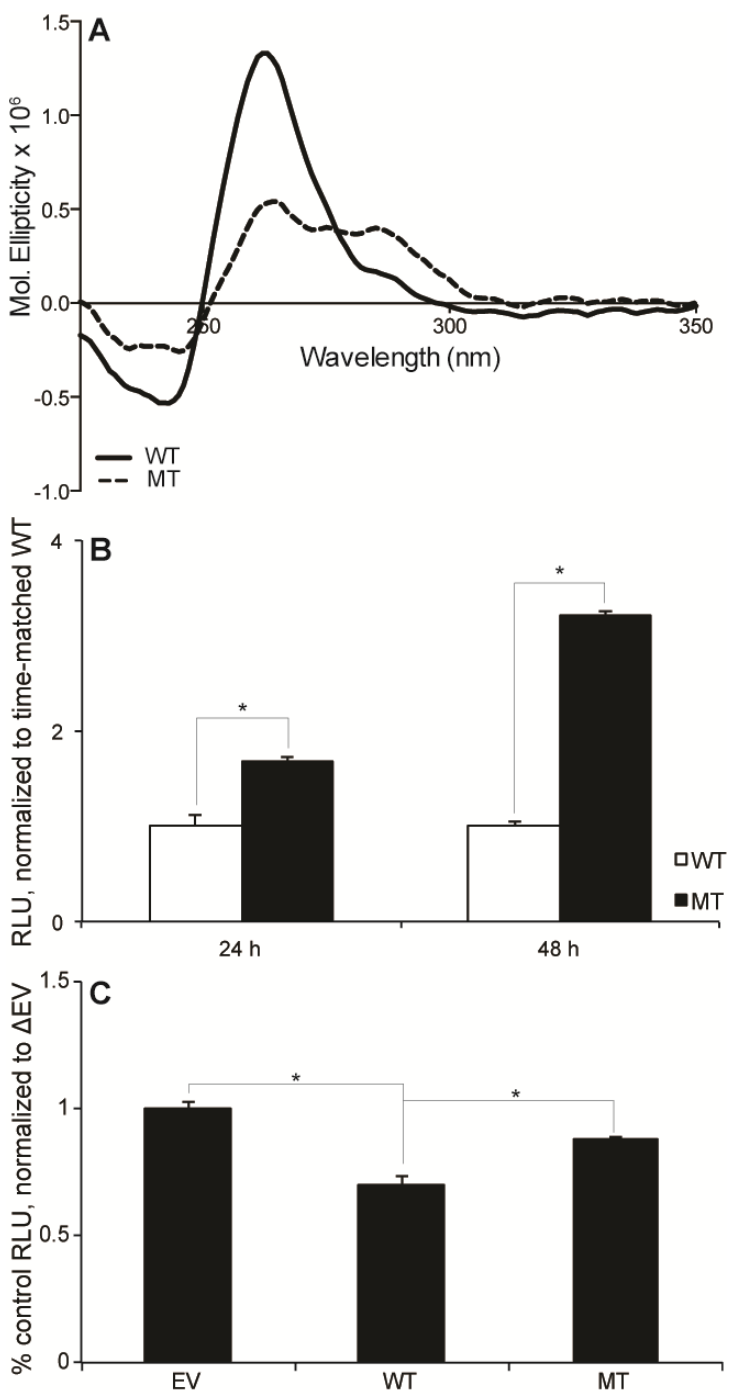
Figure 2. ( A ) CD of the WT and MT (a23d3g23) sequences in the presence of 100 mM KCl demonstrated the abrogation of strong G4 formation in the MT sequence, which was used for further biological experimentation. ( B ) These sequences were inserted into luciferase vectors and co-transfected into HEK-293 cells with control renilla luciferase plasmids for 24 and 48 h. Luciferase expression was normalized to renilla expression, and then to WT plasmid basal expression. ( C ) The effect of G4 stabilization on ADAM-15 promoter activity was further probed with the addition of 100 µM TMPyP4 for 48 h post-plasmid transfection. Luciferase expression was normalized as described in the Experimental section. All experiments were done in at least triplicate; * p <